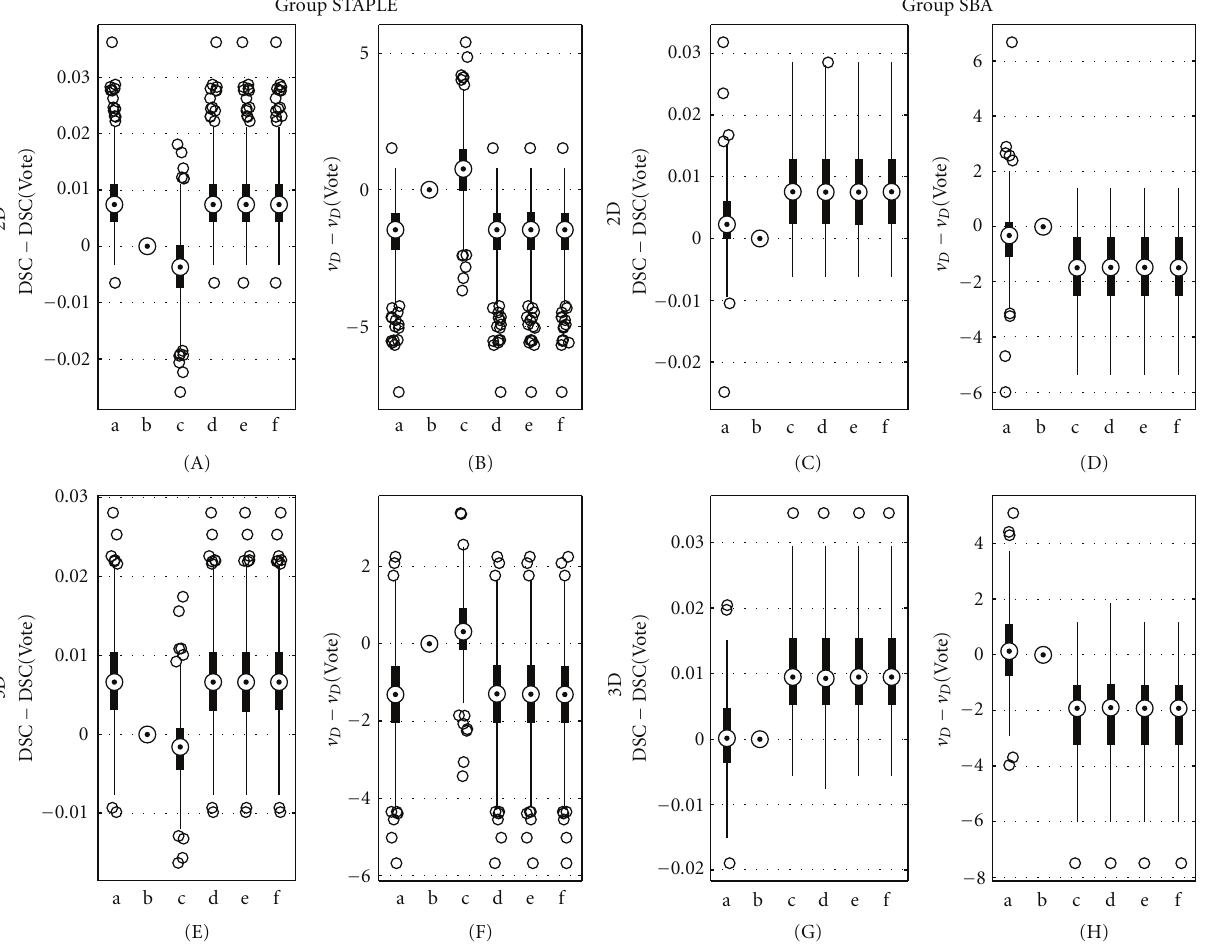
Figure 6: Boxplots of (A, C, E, and G) DSC and (B, D, F, and H) v D , centered on Vote values, for each method for the (A)–(D) 2D and (E)–(H) 3D testing sets. (a) STAPLE, (b) Vote, (c) SBA, (d) SVS-2D, (e) SVS-3D, and (f) SVS-2D&3D. The centered DSC ( v D ) corresponds to DSC ( v D ) minus DSC ( v D ) evaluated for